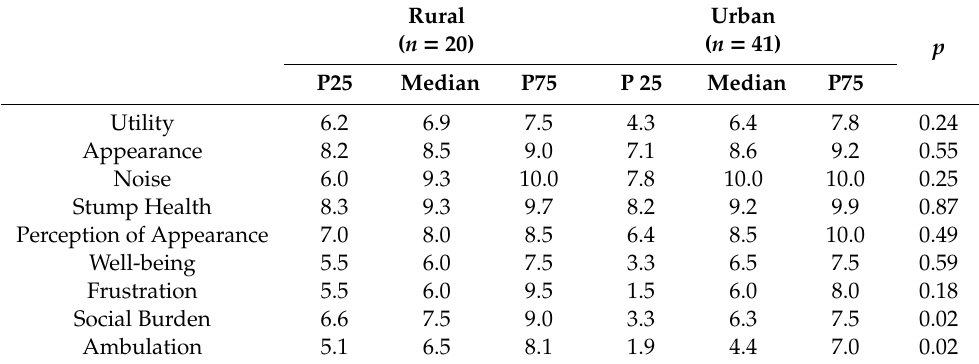
Table 5. PEQ domain levels in relation to area of residence.